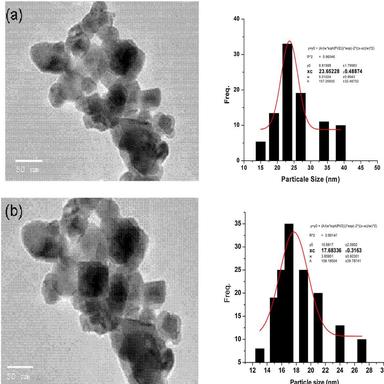
(a and b). Transmission Electron Microscopy (TEM) micrographs and the corresponding particle size distribution histograms of (a) pure SnO2 and (b) 10 at % Co-doped SnO2 nanoparticles.